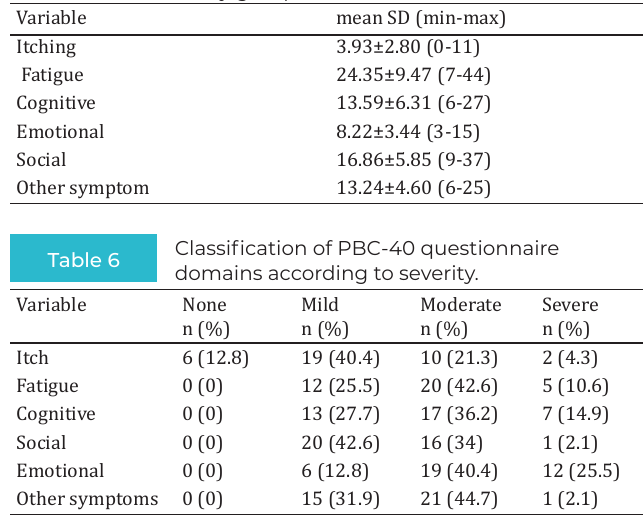
Evaluation of the PBC-40 questionnaire in the study group